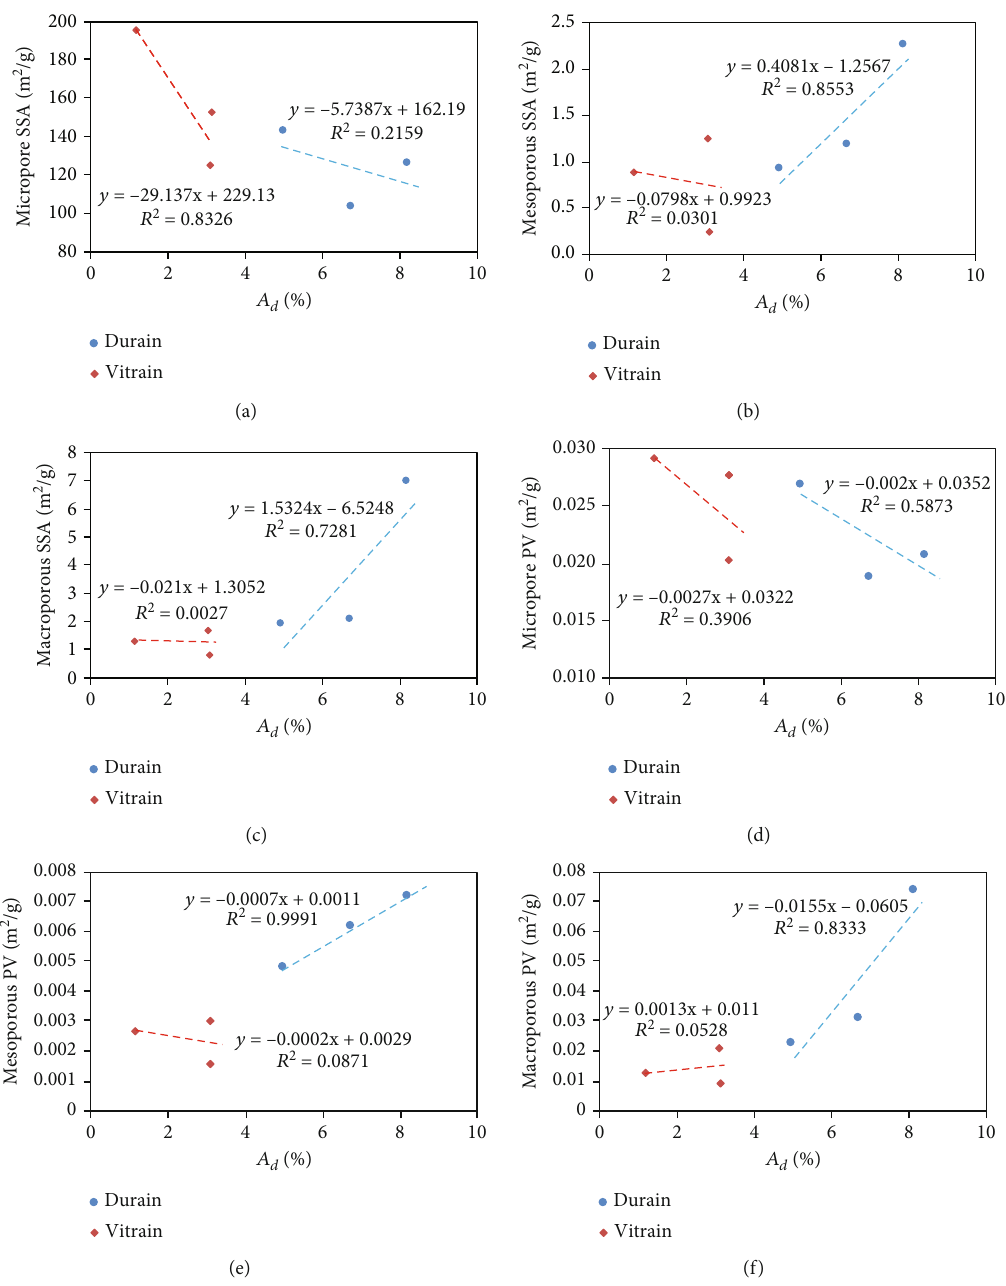
Figure 12: Relationship between ash content of vitrain and durain and micropore (a, d), mesopore (b, e), and macropore (c,